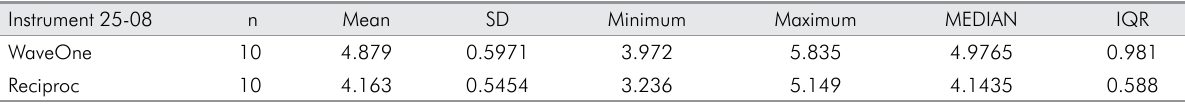
Table 1. the mean bending resistance of the instruments tested at 45°.